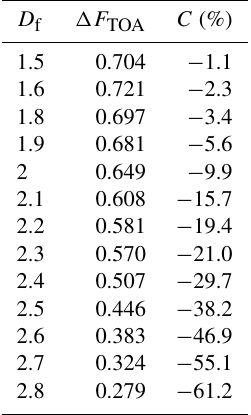
Table 4. Black carbon radiative forcing (cid:49)F TOA (Wm − 2 ) calcu- lated for various fractions of organics ( f organics ) and relative change ( C ) with respect to a reference case with f organics =